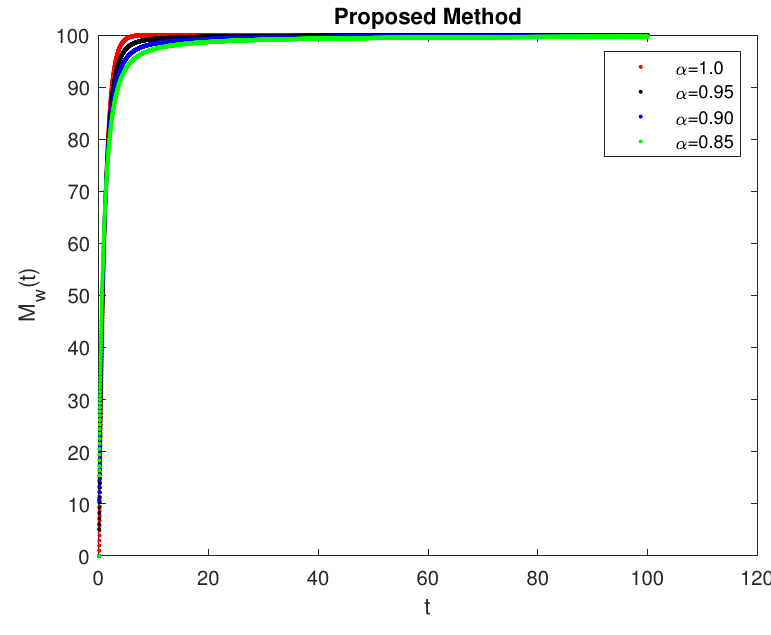
Figure 3: Numerical simulations for τ = 1 for ABC derivative.